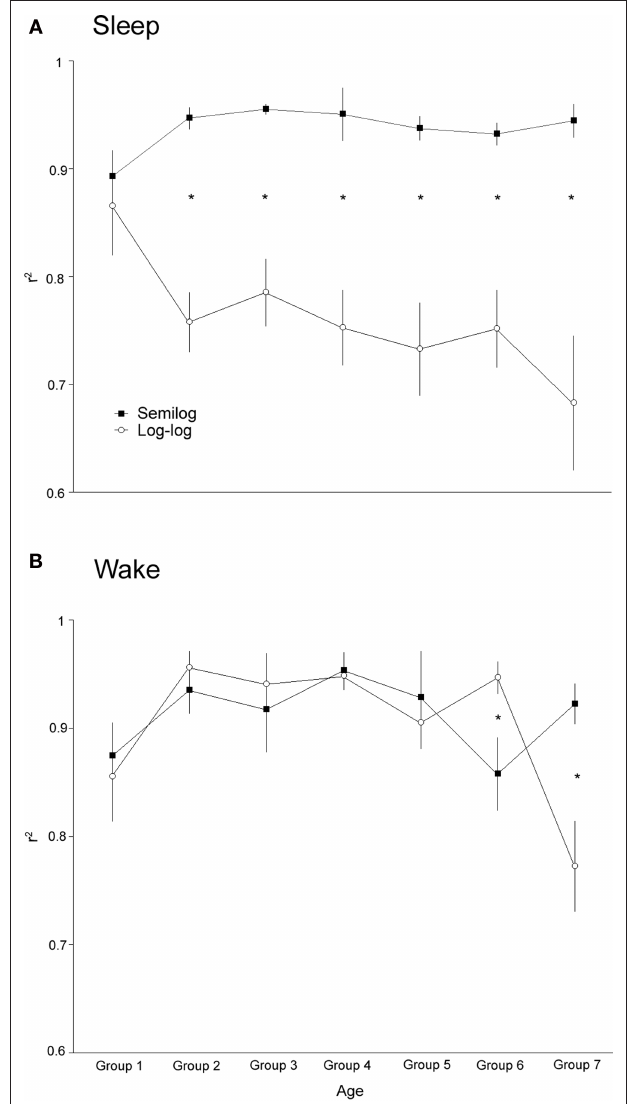
FiGure 4 | Values of r 2 produced using regression analysis of survivor data at all ages examined. For each participant the degree of fit to exponential or power-law distribution was determined. (A) Average fit with exponential and power-law distribution for sleep bouts is depicted for each age. At all ages, except for the premature infants, sleep bouts are better described by an exponential distribution. (B) Average fit with exponential and power-law distribution for wake bouts is depicted for each age. For age groups 1–5 there is no significant difference between the fit to either distribution. At age group six wake bout lengths fit power-law distributions significantly better, whereas, at age group seven the inverse is true. Significant within-age differences are represented by an